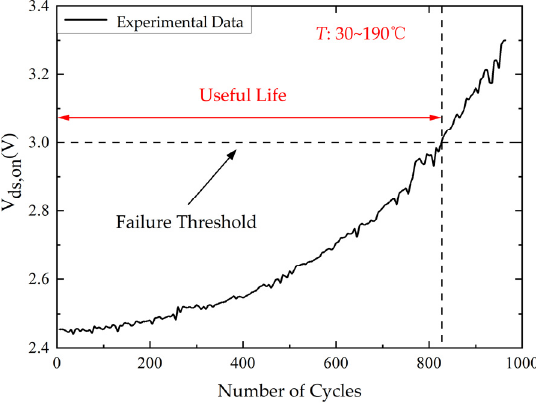
Figure 10. The experimental data of V ds,on processed by moving average filter ( Δ T = 160 °C).